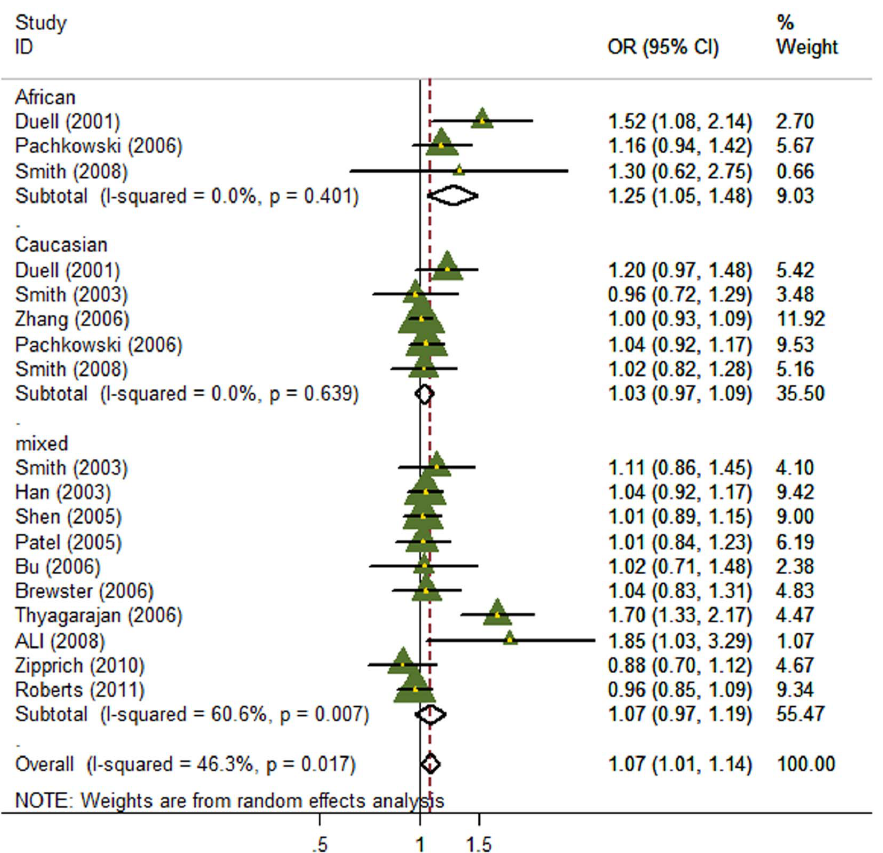
Figure 3. Forest plot of the association between the XRCC1 Arg399Gln polymorphism and breast cancer risk for the additive model.